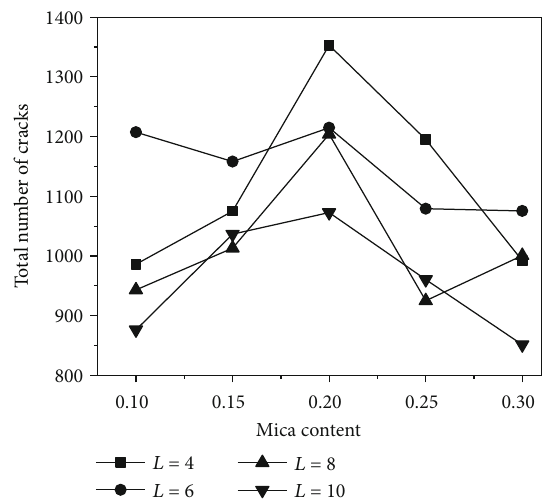
Figure 15: The relationship between the number of cracks and the content of mica.